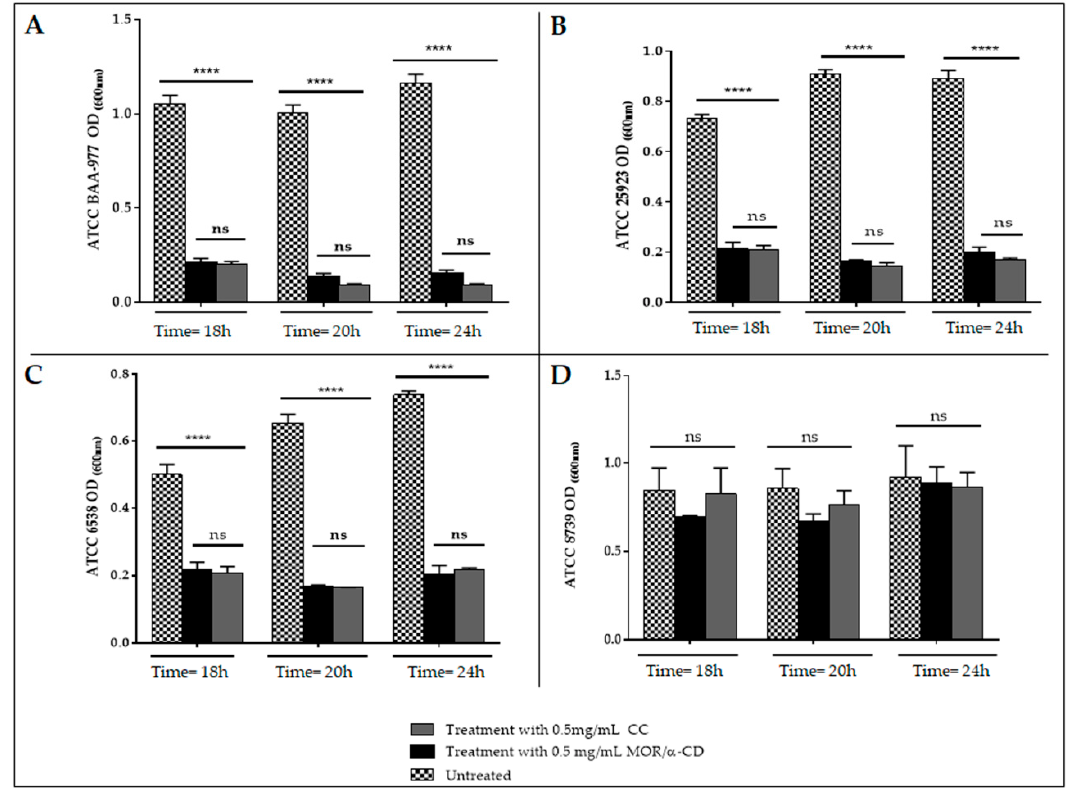
Figure 2. The MIC evaluation of MOR/ α -CD against S. aureus ATCC BAA-977 ( A ), S. aureus ATCC 25923 ( B ), S. aureus ATCC 6538 ( C ) and E. coli ATCC 8739 ( D ); MIC value of MOR/ α -CD was evaluated using a starting inoculum of 5 × 10 5 CFU/mL and measuring the optical density (OD) at 18 h–20 h and 24 h. We assessed different doses of MOR/ α -CD, but in the graph, we represented only the dose of 0.5 mg/mL, which was able to affect the growth after 24 h of incubation. Experiments were done in triplicate to obtain the mean and the standard deviation (SD). Statistical analysis (Two-way ANOVA) was performed by the GraphPad Prism6 software and the p value < 0.0001 (****) showed significant difference.